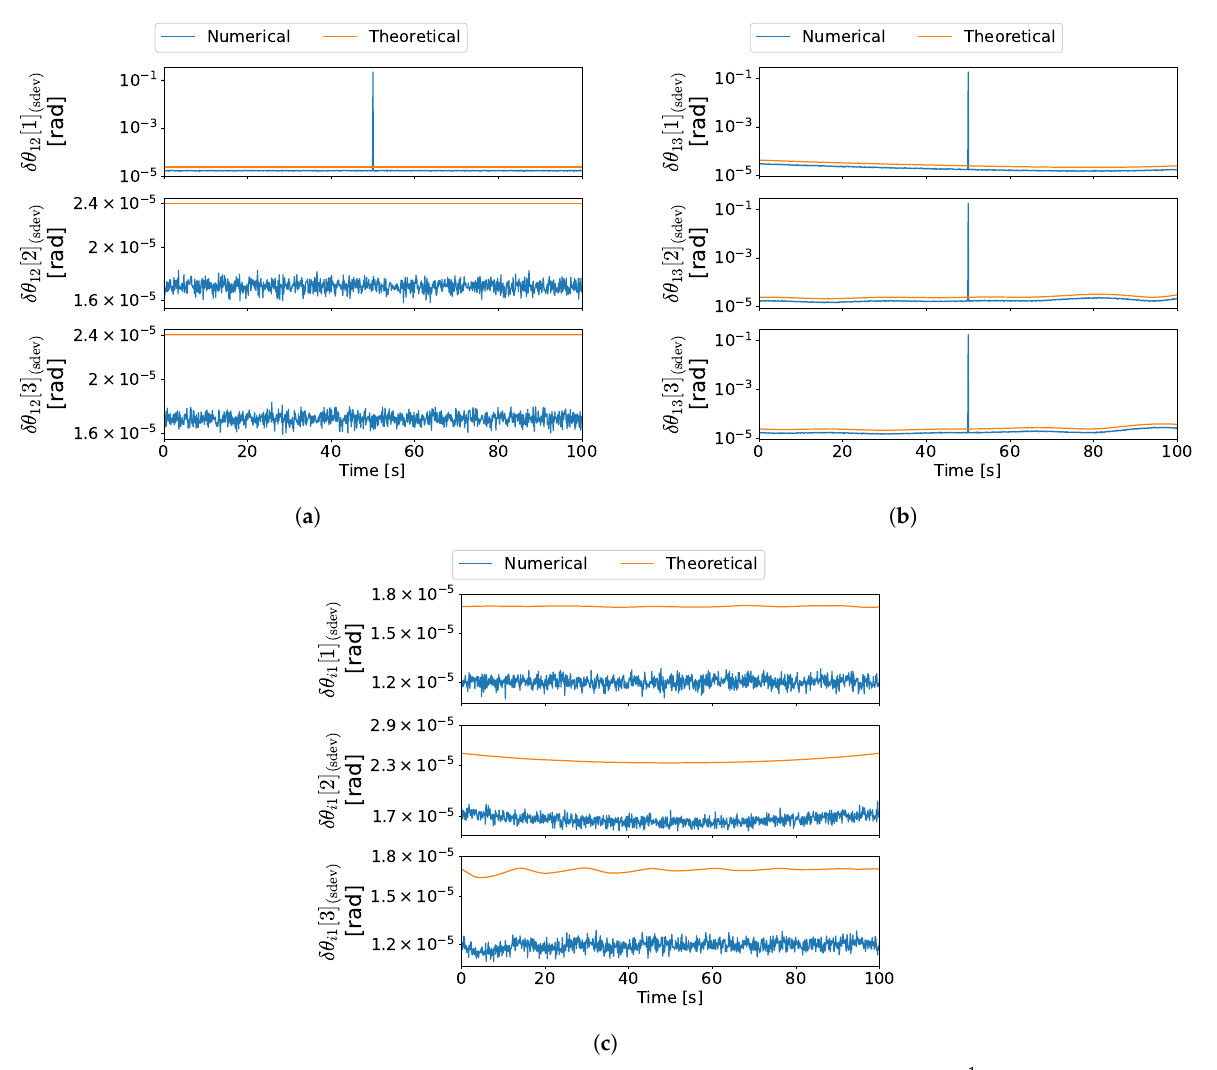
Figure 8. Attitude error standard deviations in experience 3. ( a ) R 1 experience 3, ( b ) R 1 error standard deviation in experience 3, ( c ) R I 3 experience